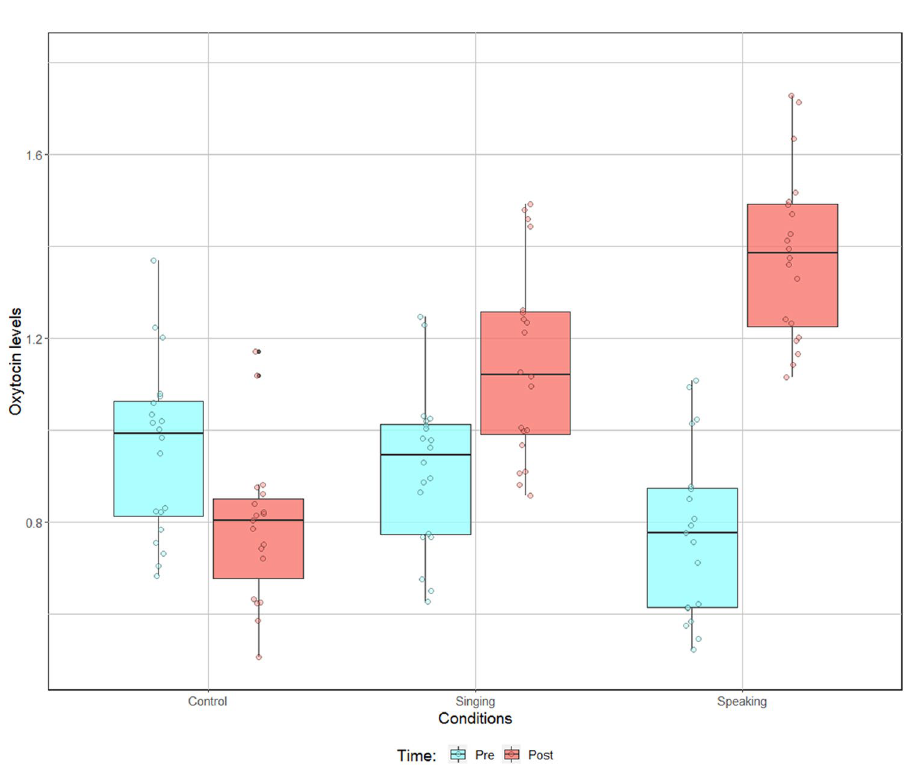
Figure 3. Preterm infants’ oxytocin levels (pg/mL) before and after painful procedures in the Control, Singing and Speaking